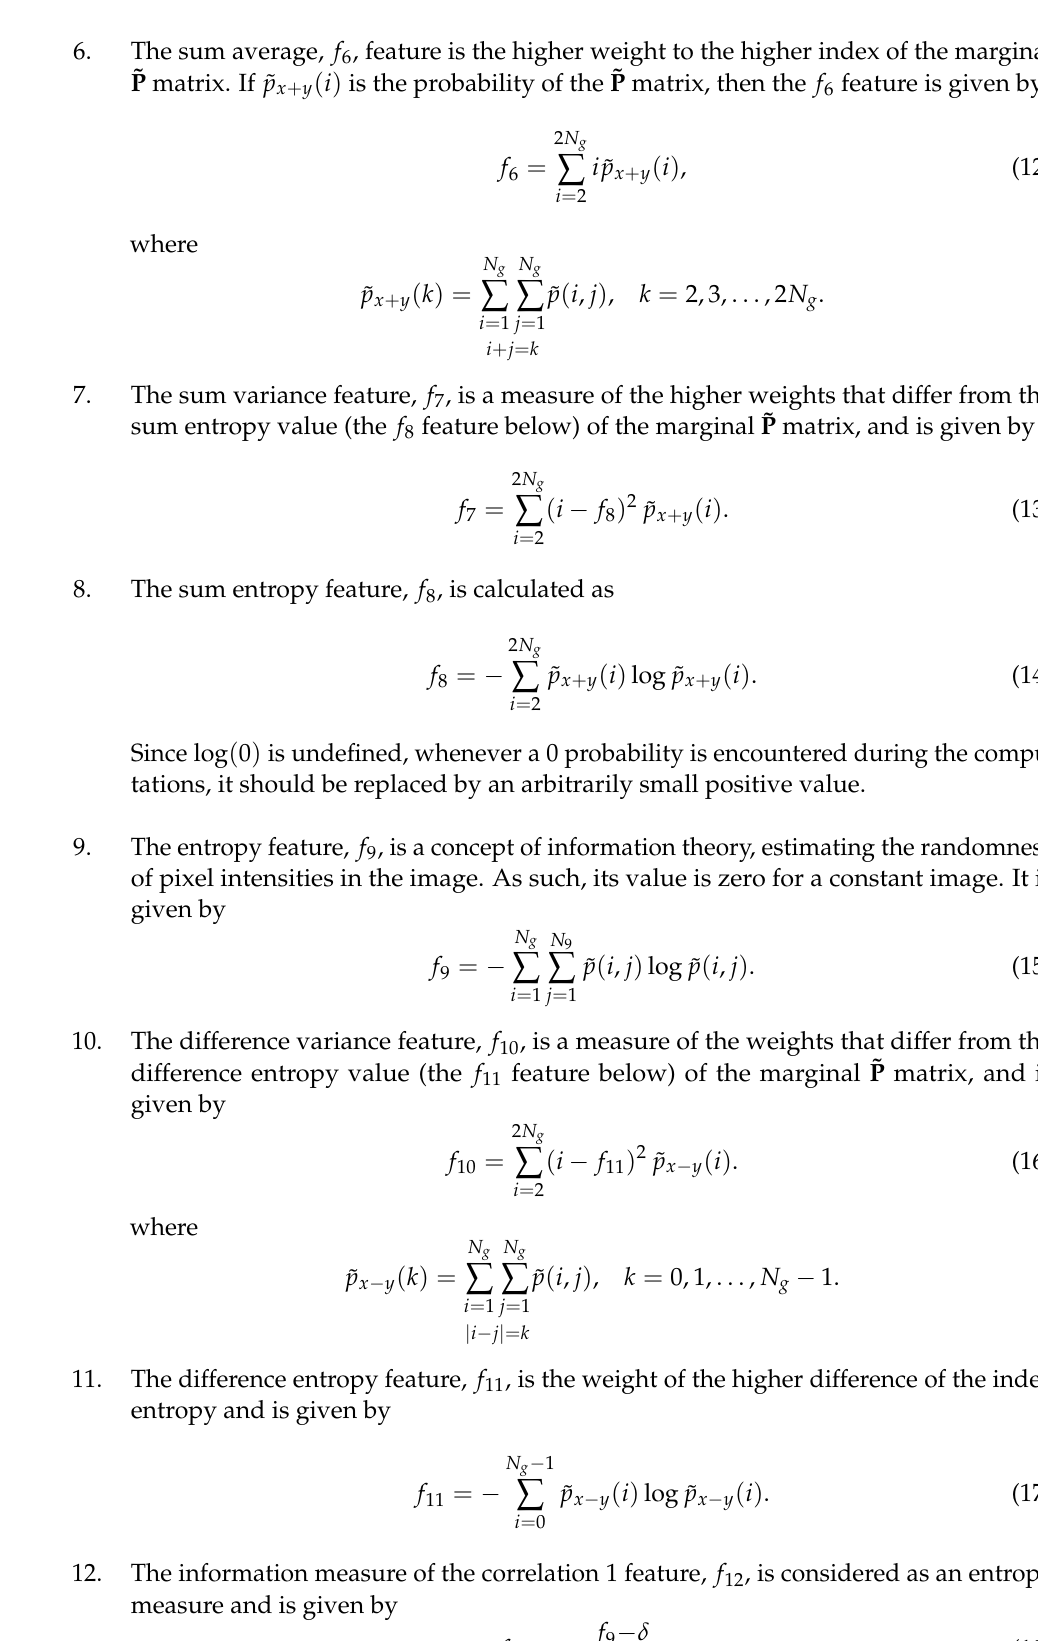
12. The information measure of the correlation 1 feature, f 12 , is considered as an entropy measure and is given